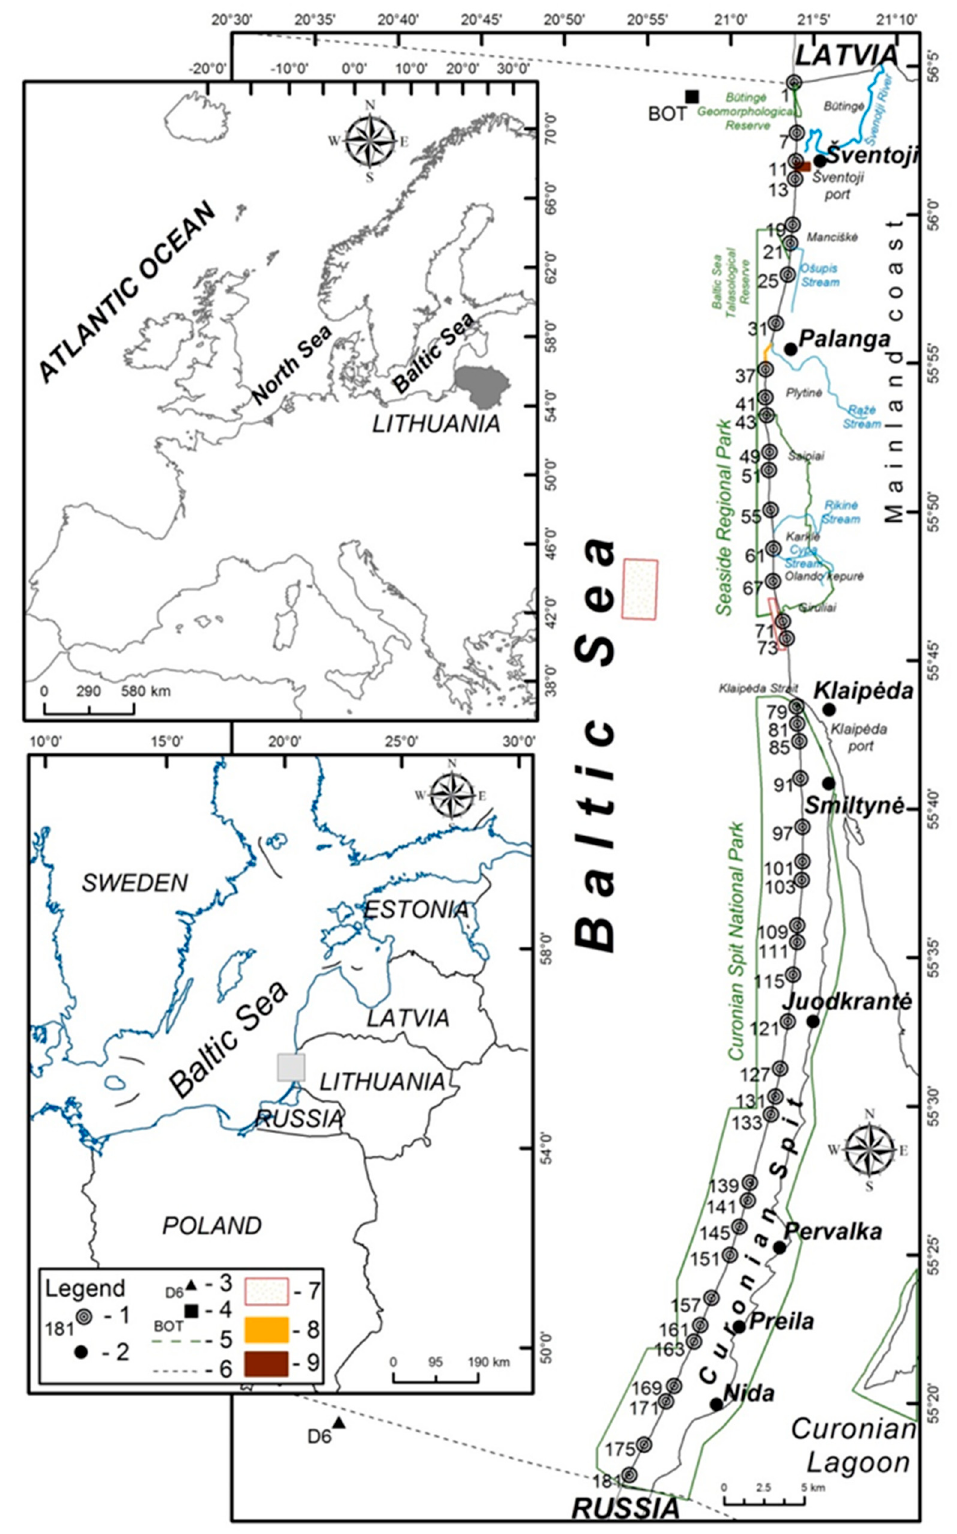
Figure 1. Study area. ( 1 ) surface sand sampling site, ( 2 ) main settlements, ( 3 ) D6 oil platform (Ru), ( 4 ) B ū ting ė oil terminal, ( 5 ) conservation areas, ( 6 ) borders, ( 7 ) offshore and nearshore dumping area, ( 8 ) beach nourishment site in Palanga, and ( 9 ) storage site of dredged bottom sediments. On the mainland coast, the average 20–100 m wide beaches are backed by foredunes 4–12 m in height or by moraine cliffs 5–24 m in height. The southern part of the mainland